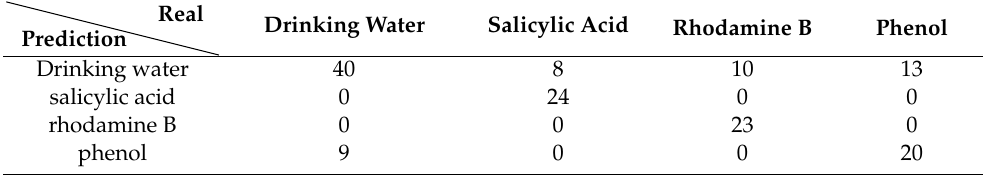
Table 3. Qualitative discrimination results of groups A and B without improved